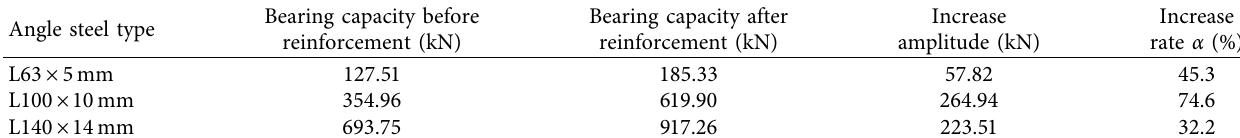
Table 2: Bearing capacity comparison table.